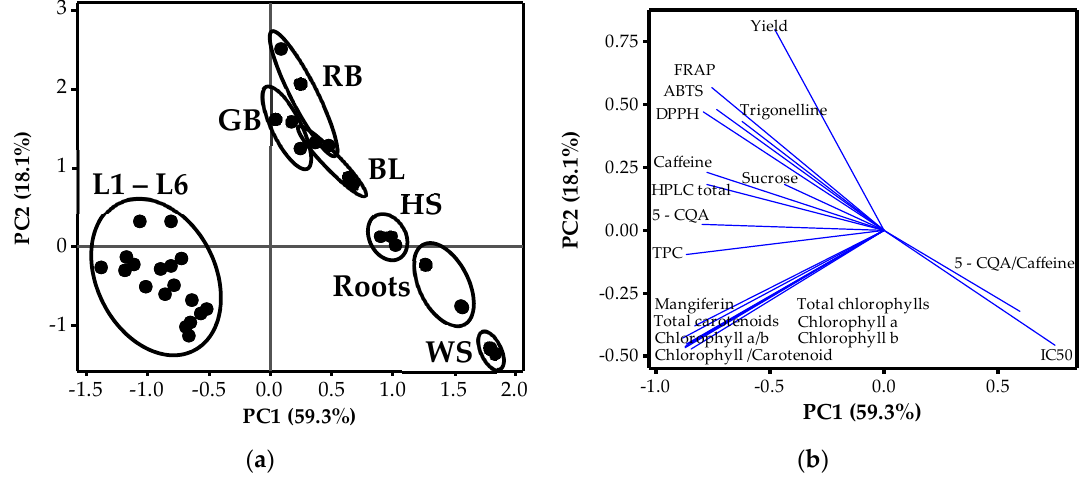
Figure 2. Principal component analysis summarizing the relationships among variables listed in Tables 2–4; ( a ) score plot of phytochemical contents according to plant organ; ( b ) loading plot of variables: sucrose, caffeine, trigonelline, 5–CQA, mangiferin, HPLC total, chlorophyll a , chlorophyll b , total chlorophyll, total carotenoids, chlorophyll a / b , chlorophyll/carotenoids and antioxidant capacity; DPPH, IC 50 , ABTS and FRAP. GB = green beans, RB = roasted beans, L1 to L6 = leaf pairs (1st–6th) from top to bottom of the coffee plant, BL = brown leaves of the first pair, HS = herbaceous stem, WS = woody stem.